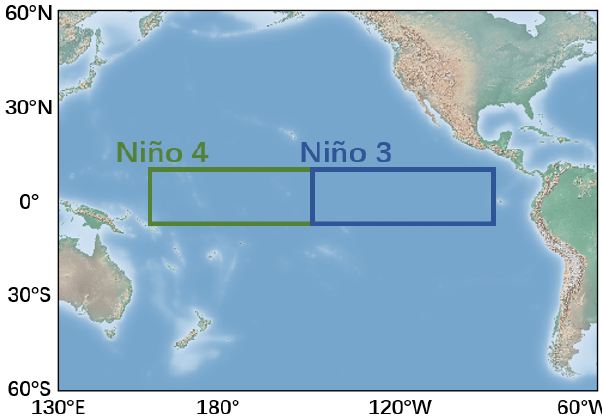
Figure 1. Regions most affected by ENSO events. The blue rect- angle covers the Niño 3 region (5 ◦ N–5 ◦ S, 150 ◦ W–90 ◦ W), and the green rectangle covers the Niño 4 region (5 ◦ N–5 ◦ S, 160 ◦ E– 150 ◦